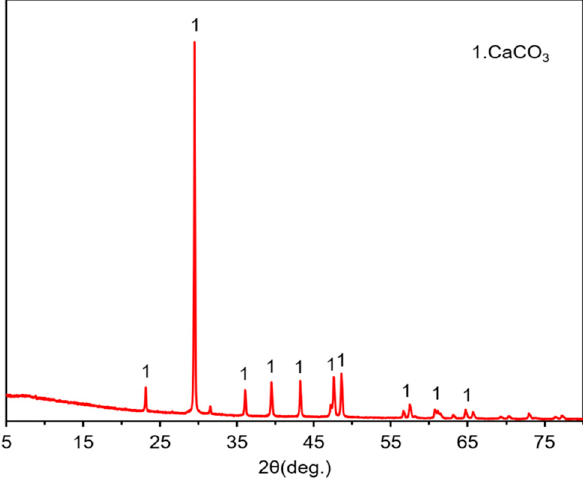
Figure 5. X-ray diffraction (XRD) analysis of EP.